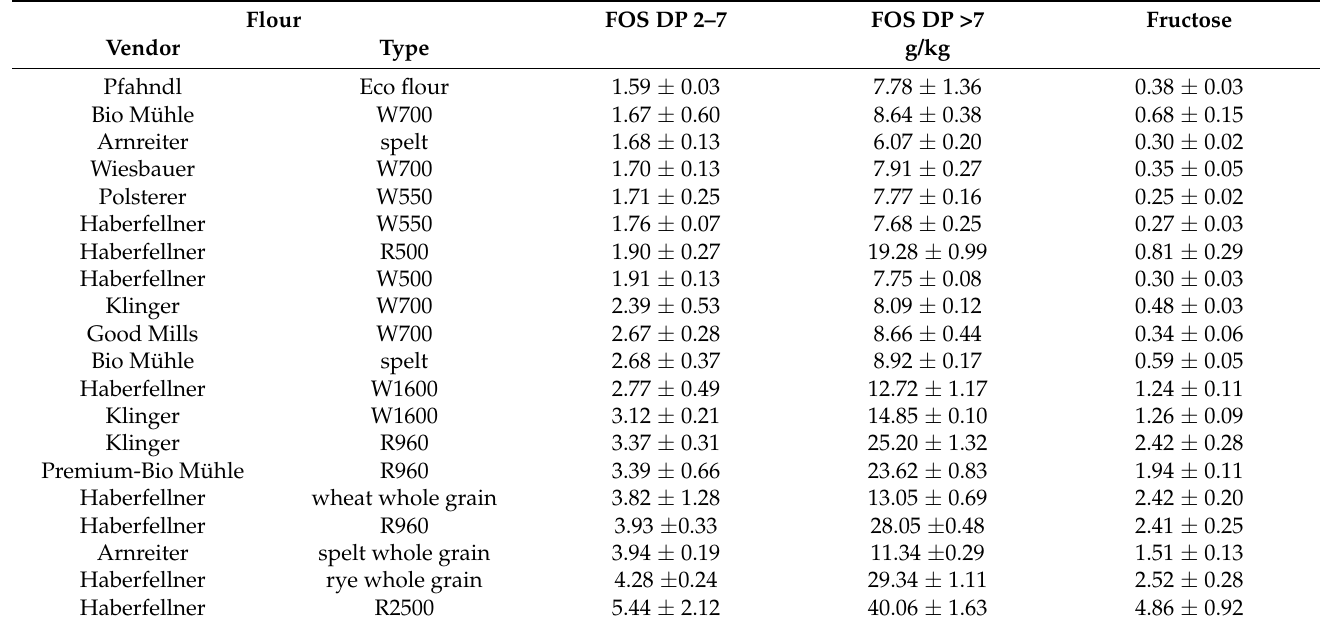
Table 3. Flours under study: milling degree, FOS, and fructose content.